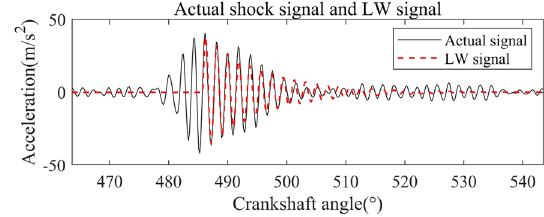
Figure 23 Actual shock signal and LW signal